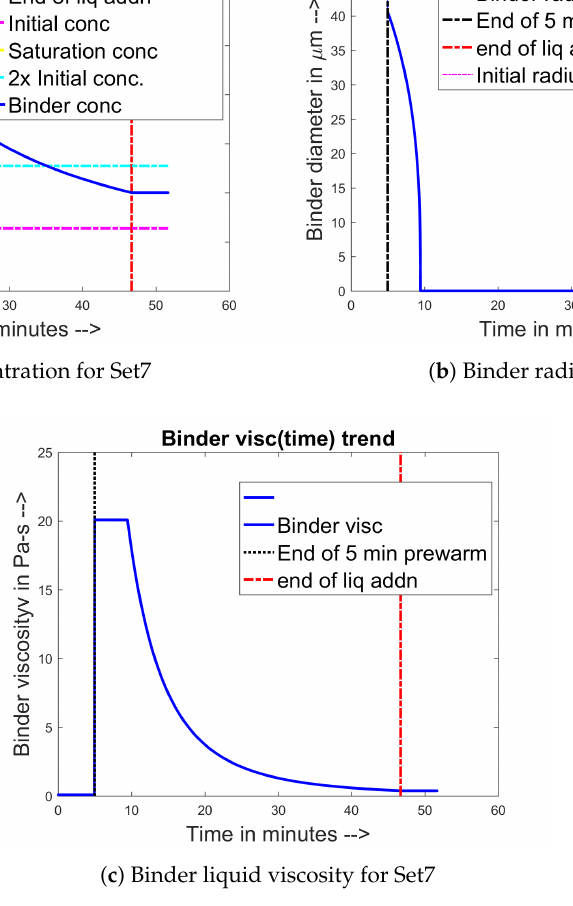
Figure 8. Simulated data for the binder liquid obtained by integrating the binder dissolution and viscosity prediction models into the main mass and energy balance model of the